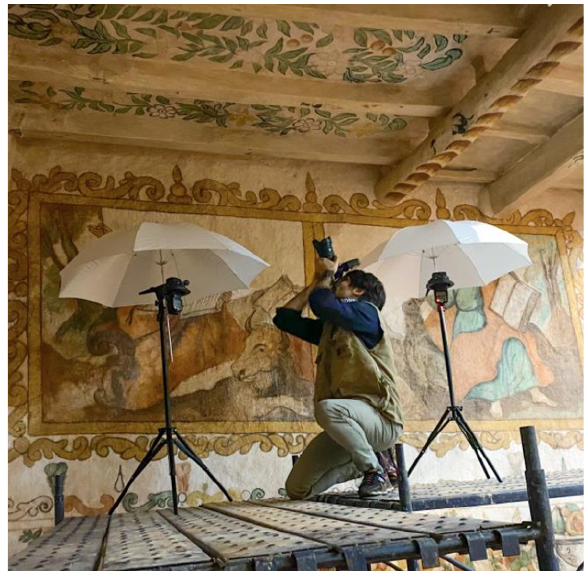
Figure 11 . Recording of decorated surfaces with scaffolding, flashes, and light-diffusors below the choir loft.